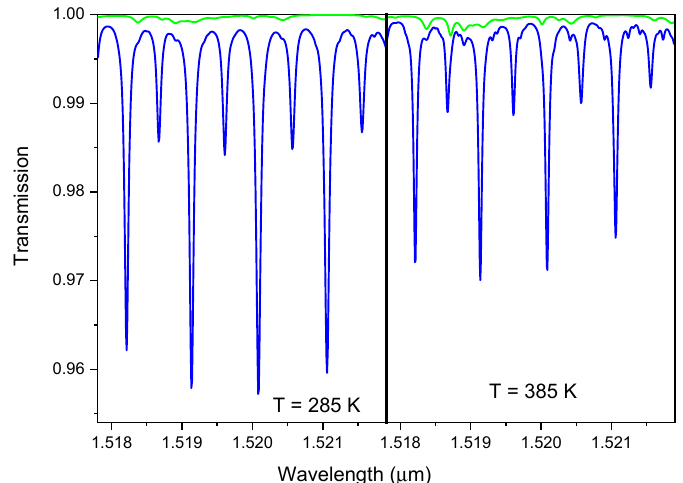
Figure 1. Comparison of the transmission spectra of an exhaust including H 2 O 10%, CO 2 10%, O 2 4% (green line), and the same mixture with addiction of C 2 H 2 1‰ (blue) at P = 1 Bar, L = 0.6 m, T = 285 K ( left ) and T = 385 K ( right